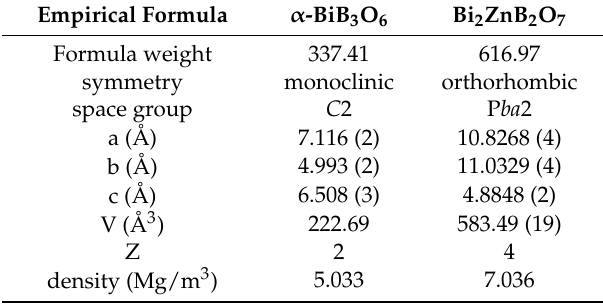
Table 1. Crystal lattice parameters for α -BIBO and BZBO crystals